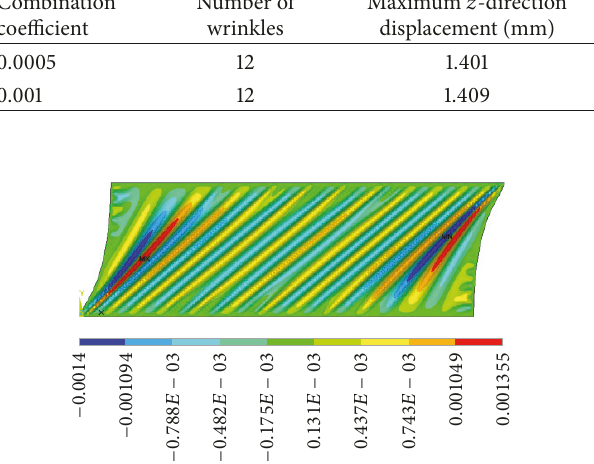
Figure 12: Out-of-plane displacement of laminated membrane.